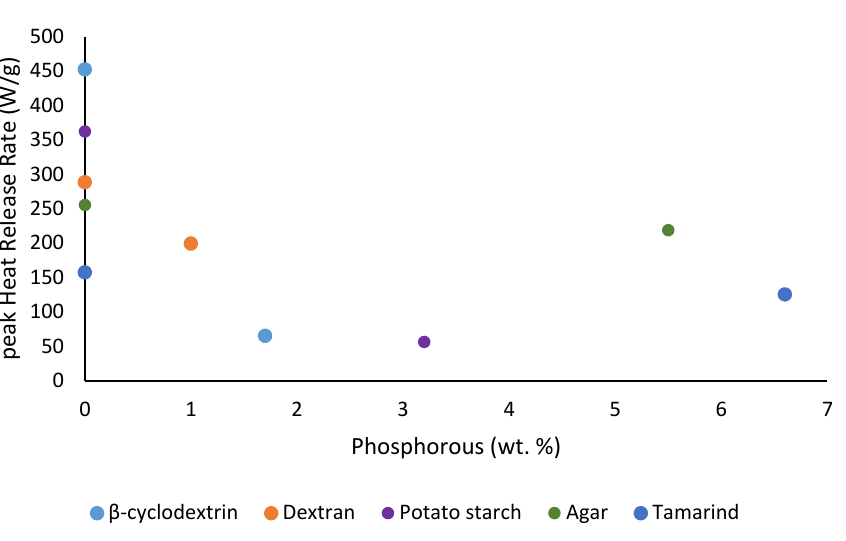
Figure 16. Plot of peak heat release rates (pHRR) versus phosphorus content (wt. %) of the substrates.